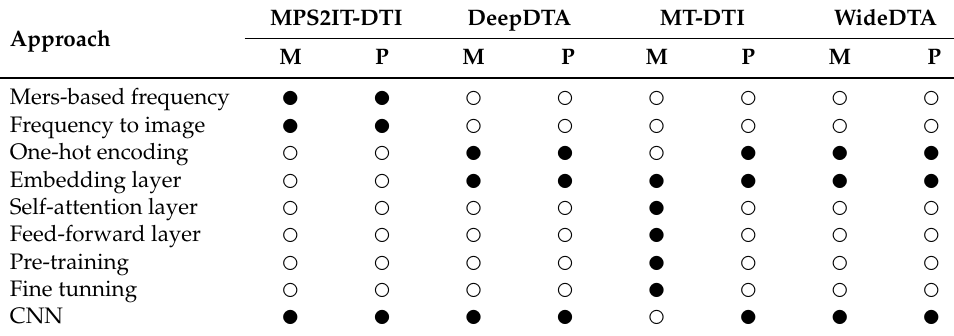
Table 5. MPS2IT-DTI model compared to baselines according to the inputs. Inputs Num. of inputs Molecule SMILES Ligand Max. Common Structure Protein Sequence Protein Motifs and Domains